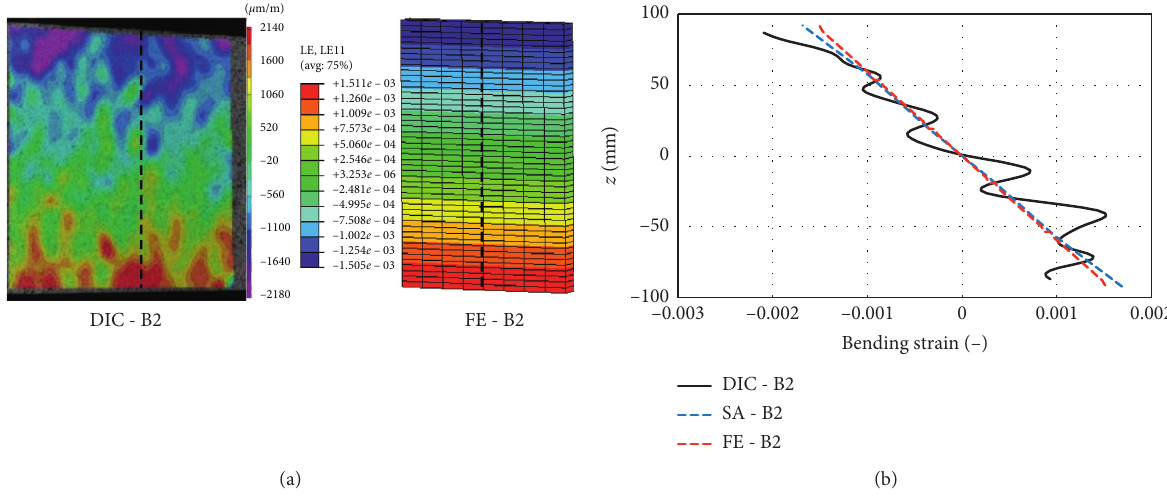
Figure 19: Colour contour plots and normal strain distribution from bending tests for B2.